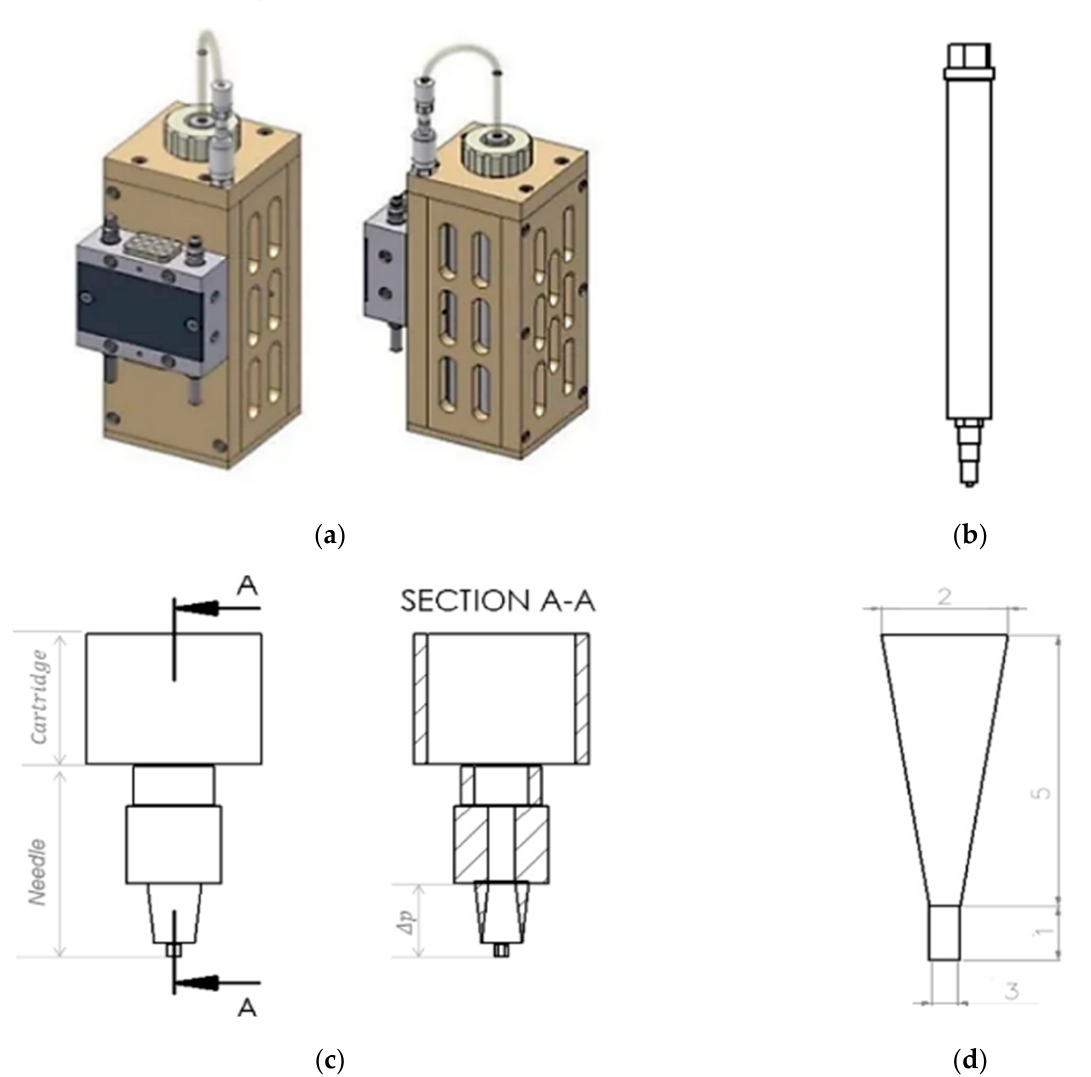
Figure 1. Picture of a high-temperature-viscous dispensing head of the 3D-Bioplotter, front view and side view ( a ); Drawing of a stainless steel cartridge, with luer-lock adapter, cartridge cap, and Fastflow needle from EnvisionTEC ( b ); Drawing of the lower part of the cartridge and the needle, front view and inside view (section A-A) ( c ); Drawing of the lower part of the needle, considering the pressure drop in the upper part of the static needle. Thus, the length of the lower part of the needle is equal to 6 mm and the diameter of the lower part of the needle is 1.15 mm ( d ) From SolidWorks ® 2020, courtesy of EnvisionTEC GmbH, Gladbeck, Germany.